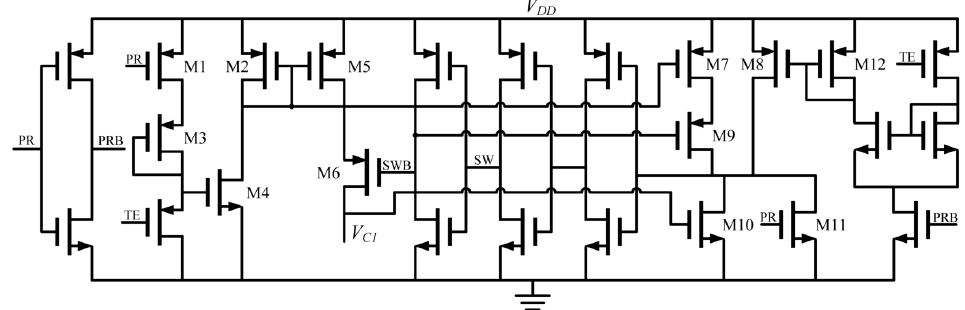
Figure 6. The start-up circuit.